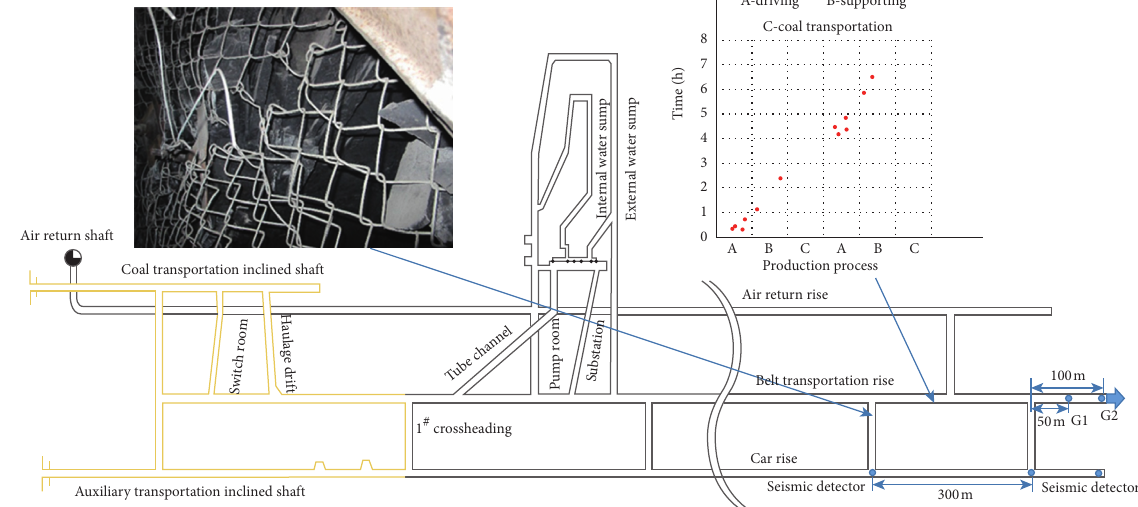
Figure 1: Roadway layout plan.